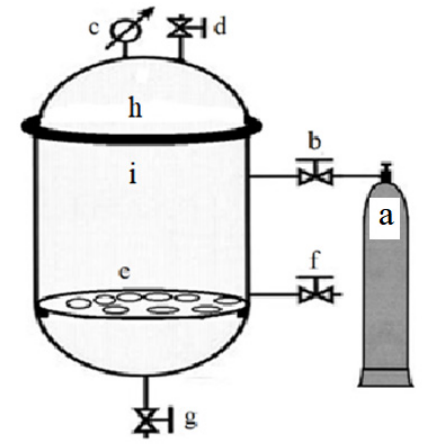
Figure 1. Schematic representation of the pressurized reactor configuration: (a) compressed CO 2 ; (b) pressure regulation valve; (c) precision manometer; (d) loading opening for liquids with the decompression valve; (e) removable stand to hold samples; (f) sample intake valve; (g) exhaust valve; and (h) upper cover of the reactor hermetically fixed to the lower part (i) via